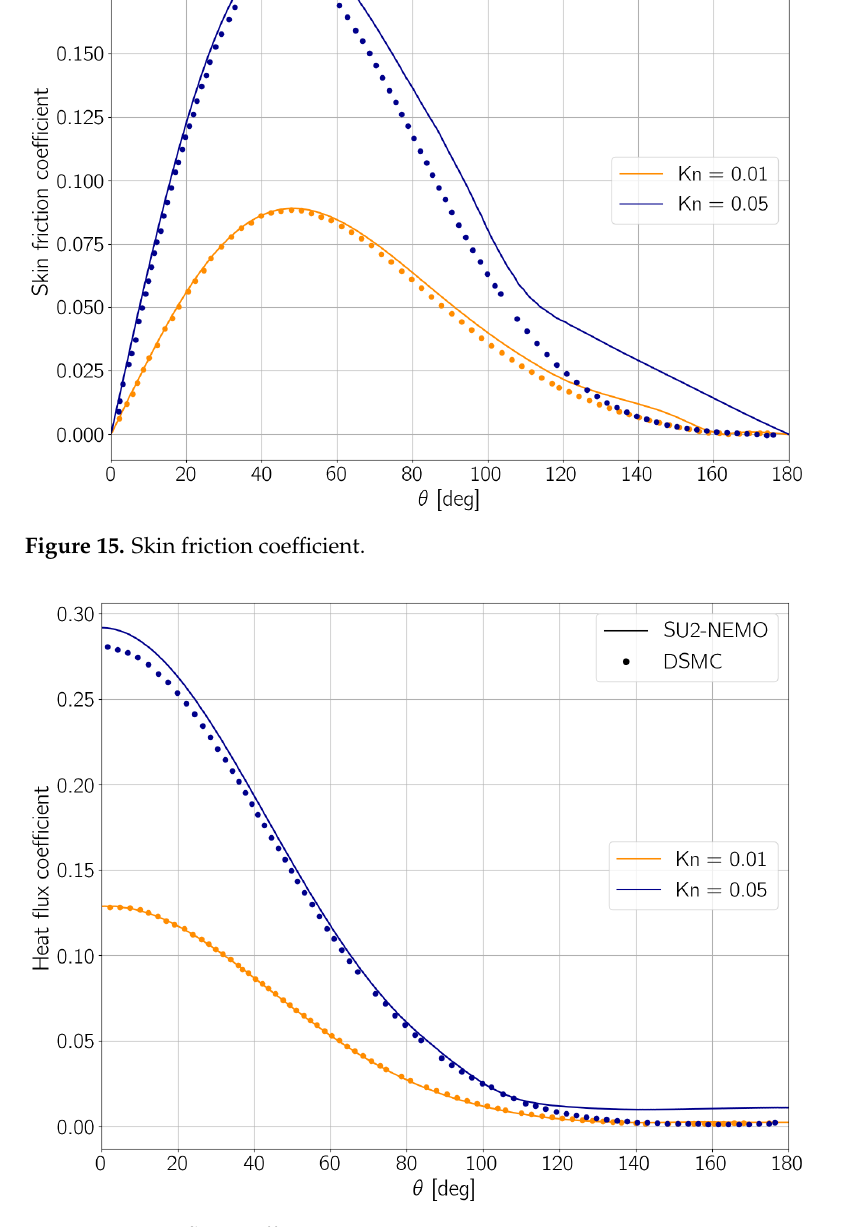
Figure 16. Heat flux